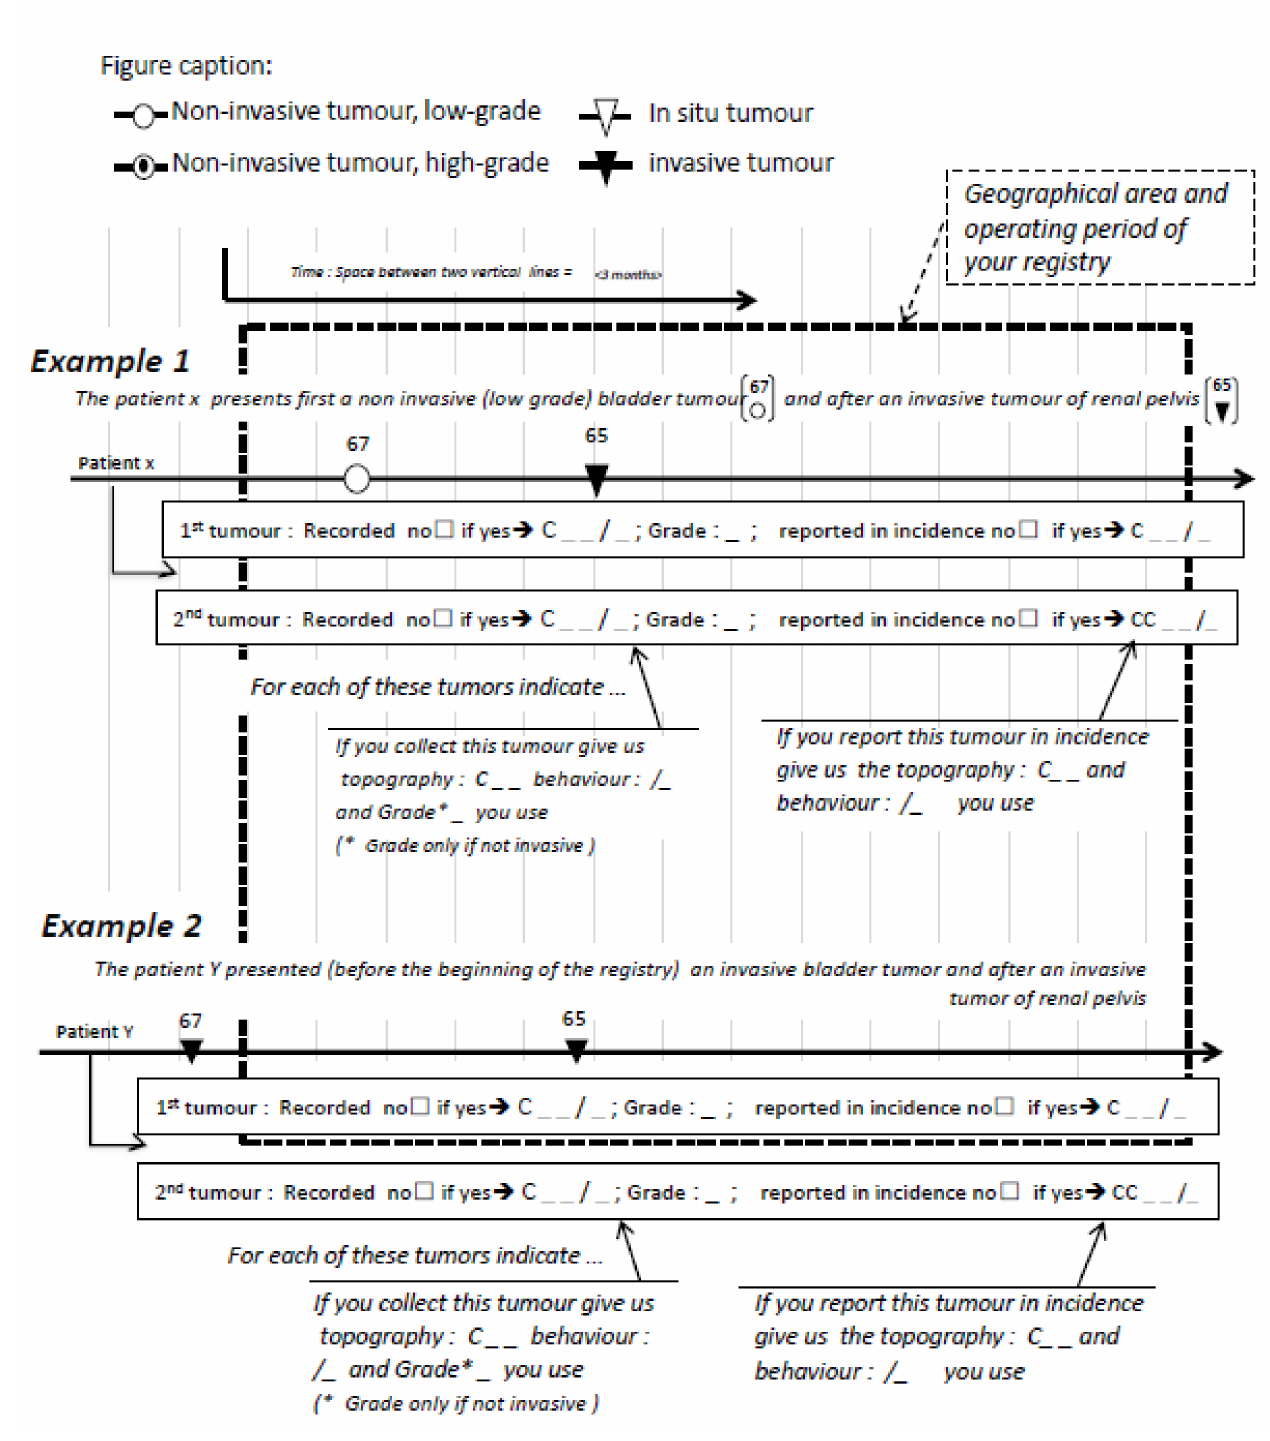
Figure A1. Filling instructions for the first